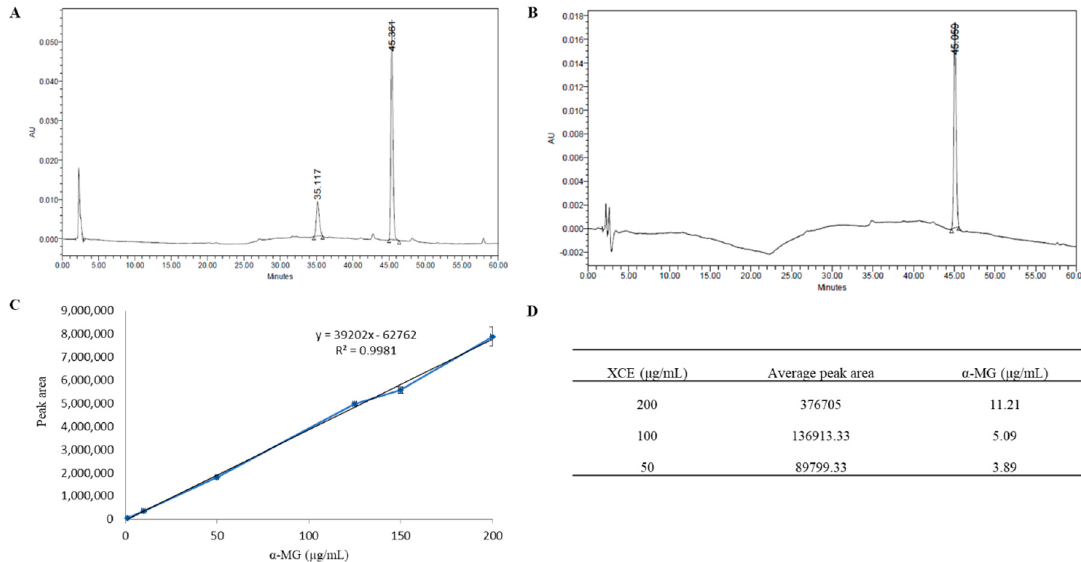
Figure 1. Crude xanthone extraction. High performance liquid chromatography (HPLC) chromatogram profile of ( A ) xanthone crude extract (XCE) and ( B ) pure α -mangostin ( α -MG) samples. The same characteristic peak was identified at the same retention time of 45 min. Standard curve of pure α -MG ( µ g/mL) ( C ) was plotted to determine xanthone concentration in XCE. ( D ) showed the total α -MG content within XCE ( µ g/mL). Error bars showed the standard error of the mean (SEM).